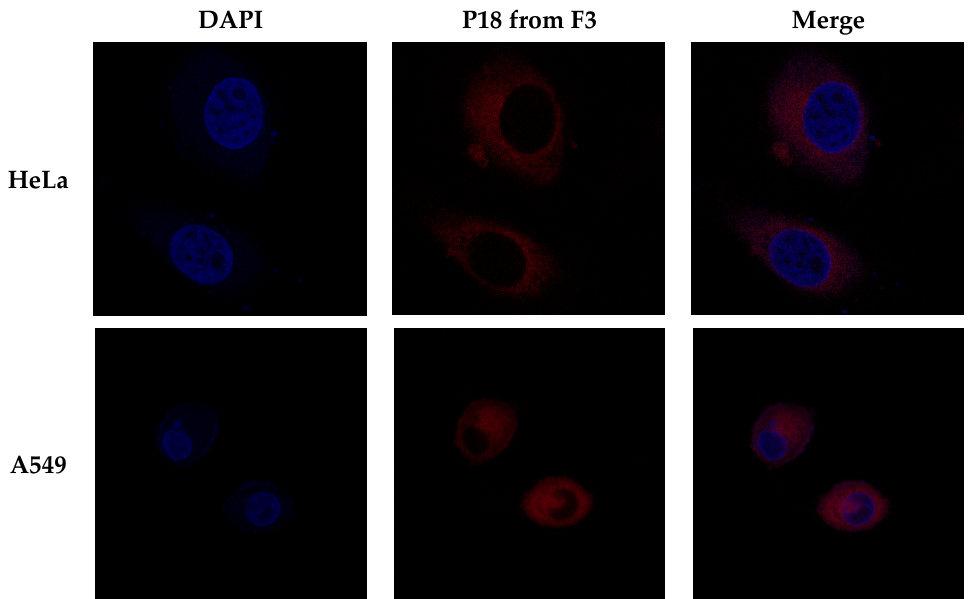
Figure 10. Confocal images of P18 cellular uptake for two cancer cell lines (HeLa and A549) following a 24 h exposure of F3. DAPI (diamidino-2-phenylindole): nuclear dye agent (blue); P18: purpurin-18 (red).